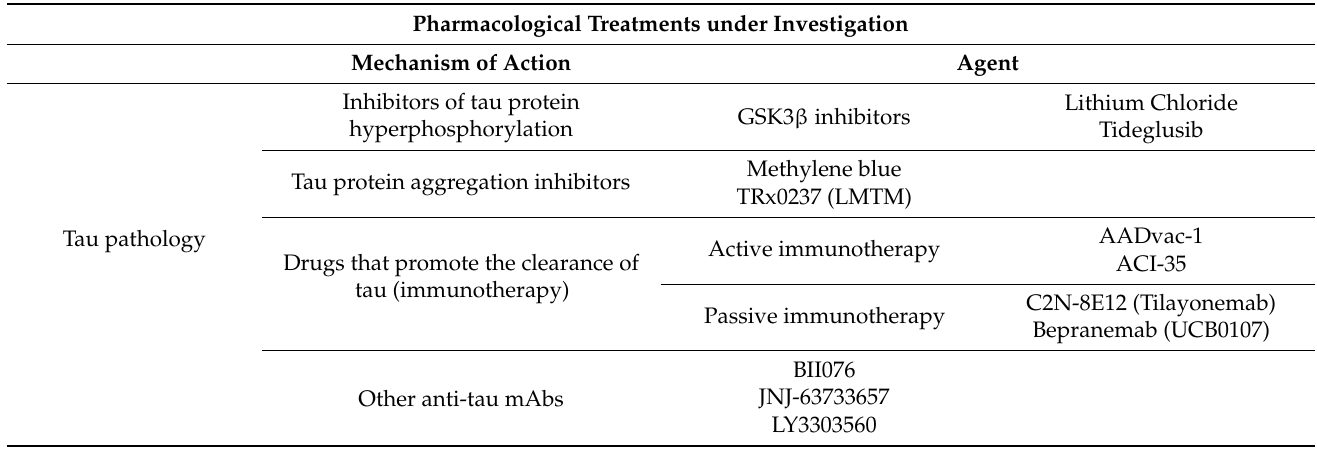
Table 2. Pharmacological treatments under investigation related to tau